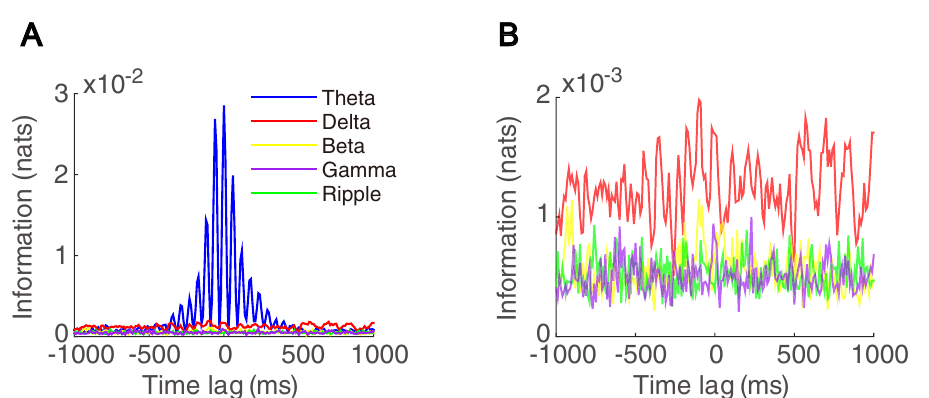
Figure 3. Interaction between a theta-driving neuron and waves over different frequency bands in the AE state. ( A ) Time-delayed mutual information between the waves of different frequency bands and the firing activity of a theta-driving neuron. The waves of the theta band (4–12 Hz) (blue), the delta band (1–4 Hz) (red), the beta band (12–30 Hz) (yellow), the gamma band (30–100 Hz) (purple), and the ripple band (100–250 Hz) (green) are obtained by filtering the original LFP signal. ( B ) Zoom-in of A but without the case of the theta